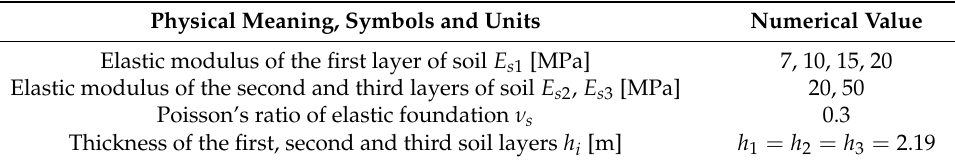
Table 4. Physical parameters of the single pile and foundation in the parameter analysis. Physical Meaning, Symbols and Units Numerical Value Elastic modulus of the first layer of soil E s 1 [MPa] 7, 10, 15, 20 Elastic modulus of the second and third layers of soil E s 2 , E s 3 [MPa] 20, 50 Poisson’s ratio of elastic foundation ν s 0.3 Thickness of the first, second and third soil layers h i [m]